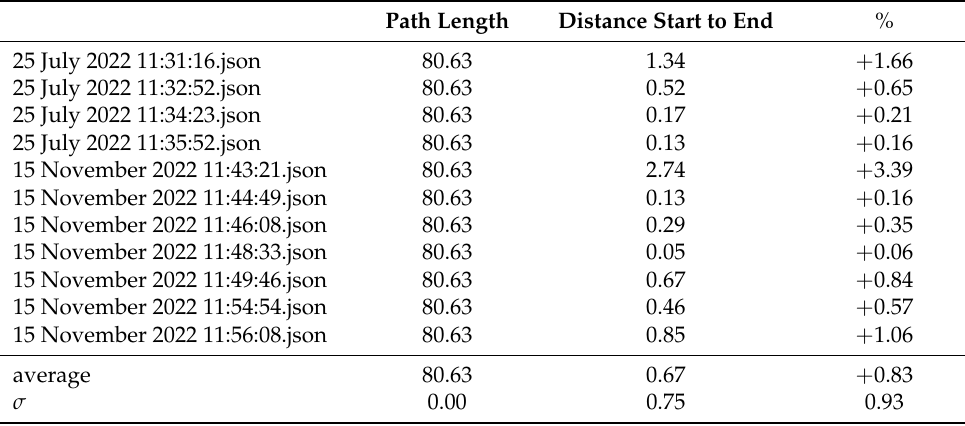
Table 9. Evaluation (Dataset 1): AR; distance between start and